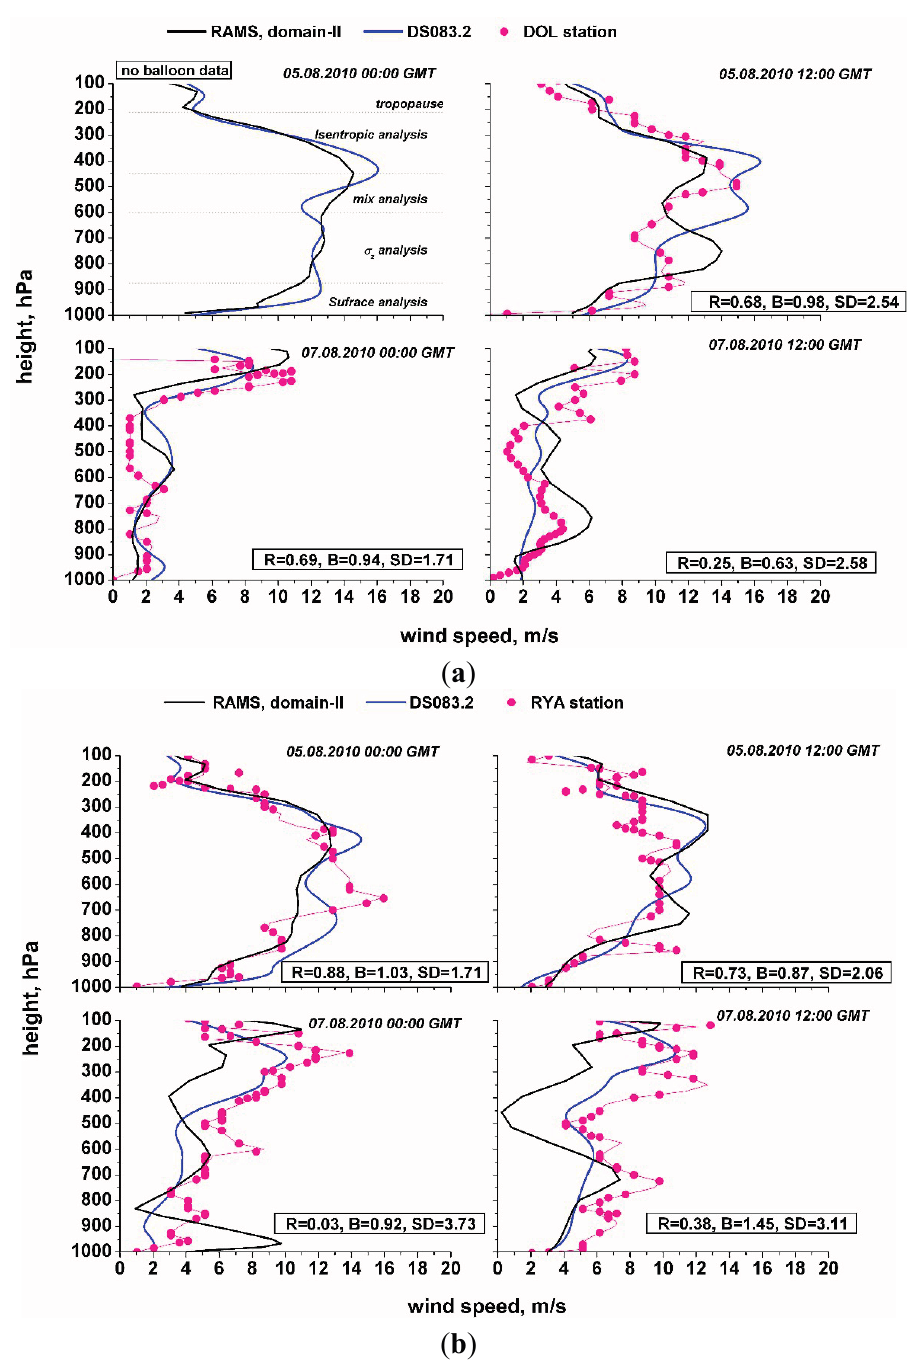
Figure 3. ( a ) Experimental (balloon at DOL station) and model (RAMS/HYPACT for the domain-II) wind profile (wind speed in the horizontal plane). The input of the DS083.2 meteorology field with resolution 1° × 1°, which was used as model initial and boundary conditions, is shown with thin grey lines. The analysis nudging (ODA) elements and the tropopause are marked in (a) (5 August 2010); ( b ) Same as for Figure 3a, but for RAY